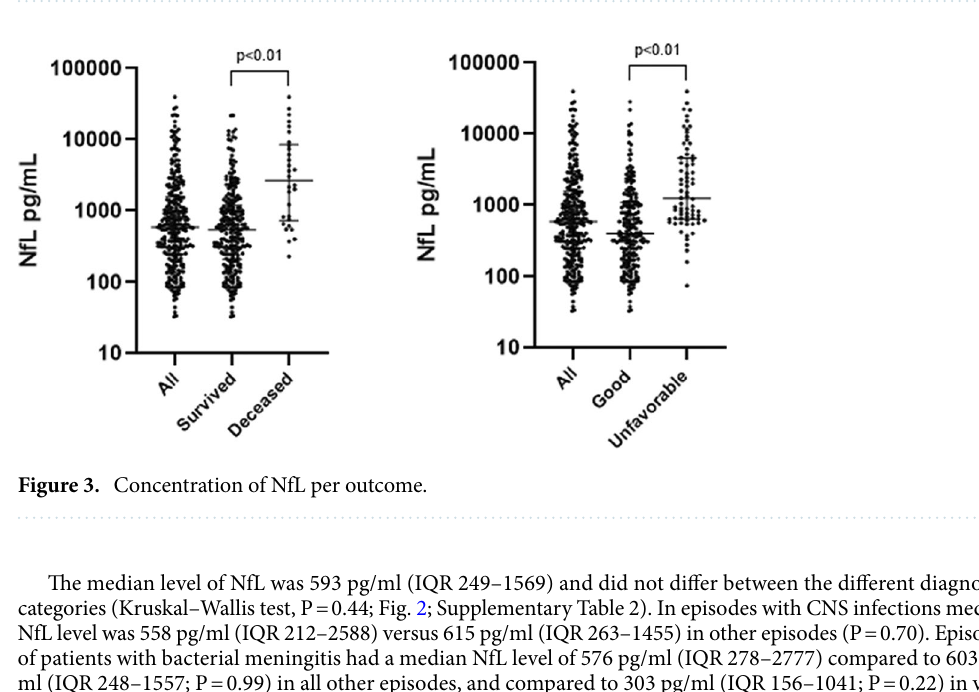
Figure 2. Concentration of NfL per diagnosis.